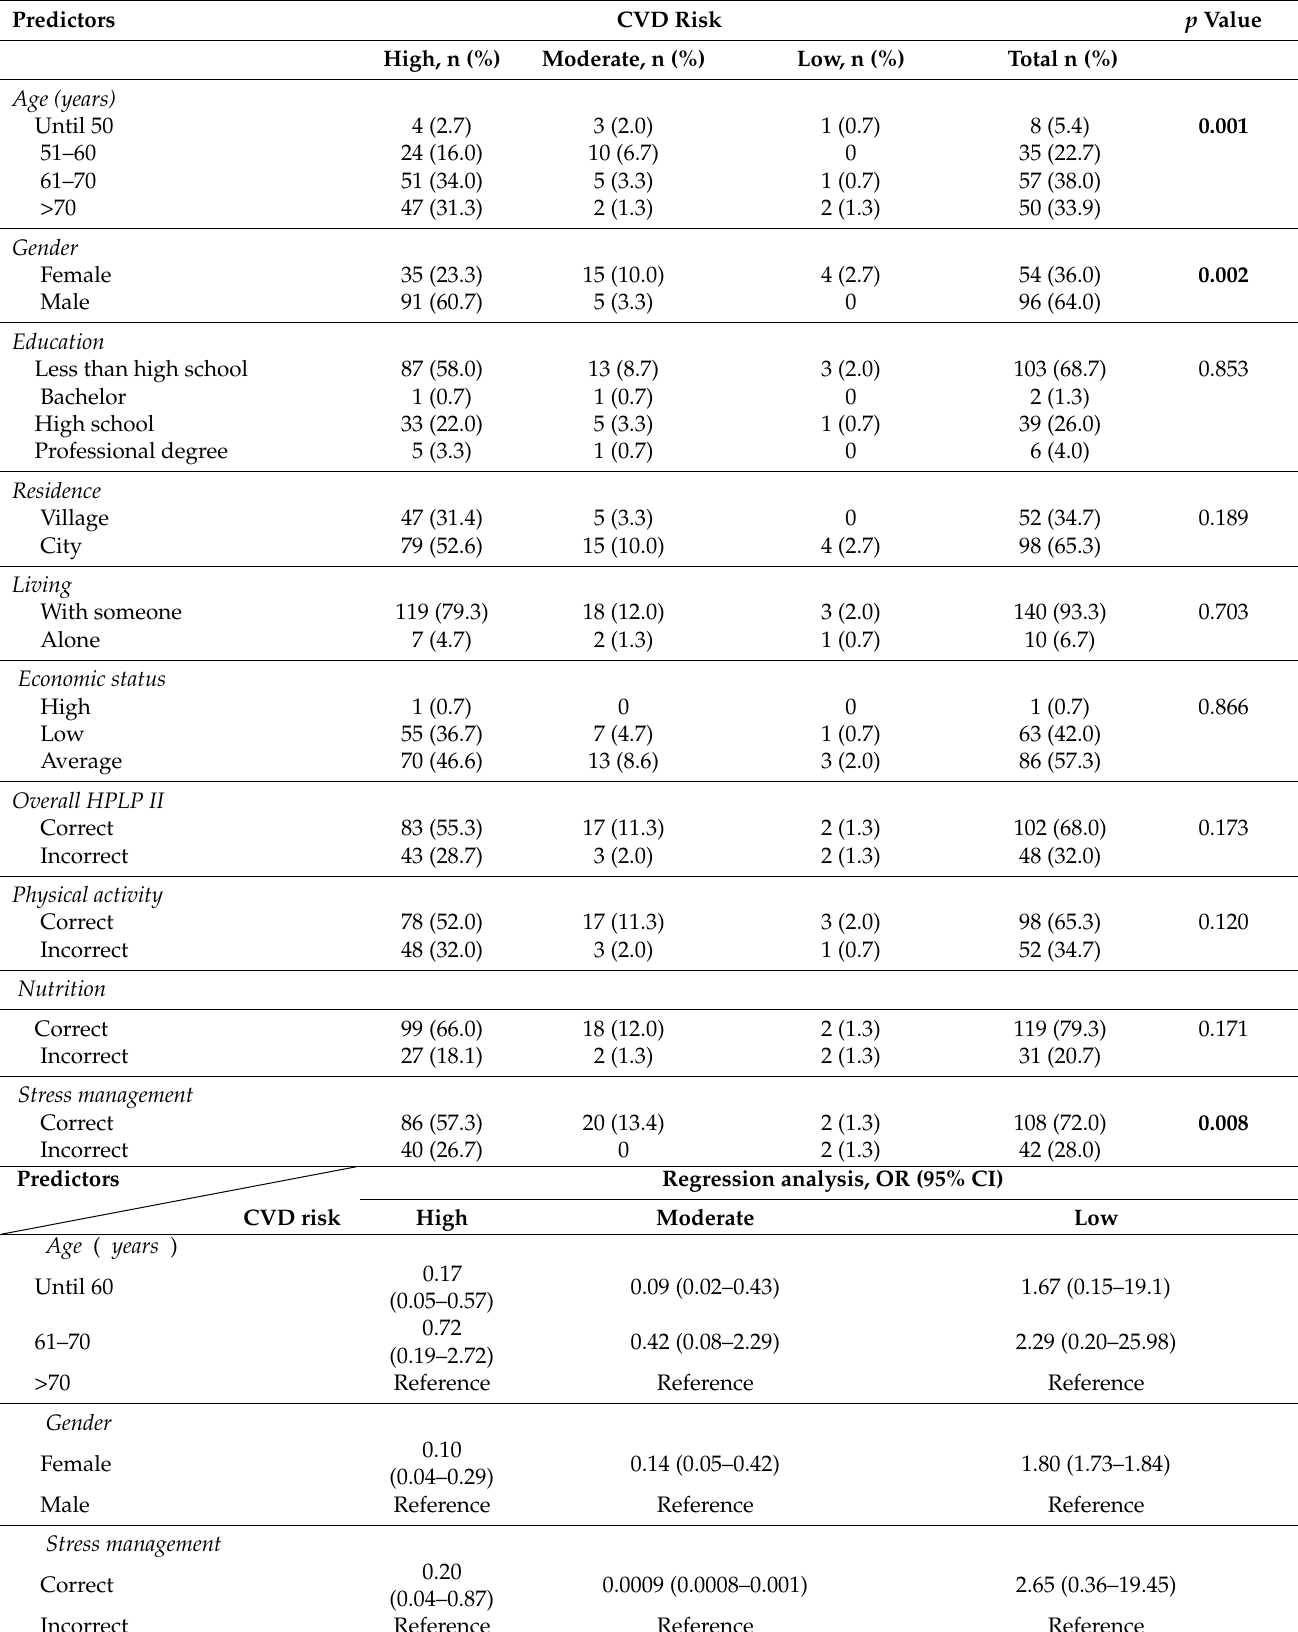
Table 4. Predictors of cardiovascular disease risk (Framingham Risk Score) and regression